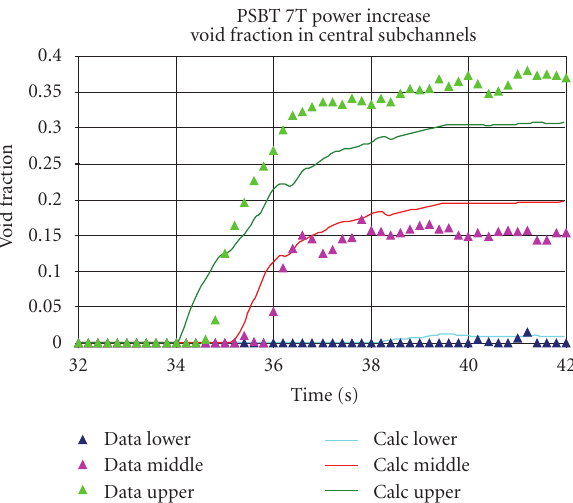
Figure 8: Comparison of void fraction transient predicted by CATHARE 3 and measured in PSBT 7TPI test. PSBT test 7TTI comparison CATHARE3 versus data